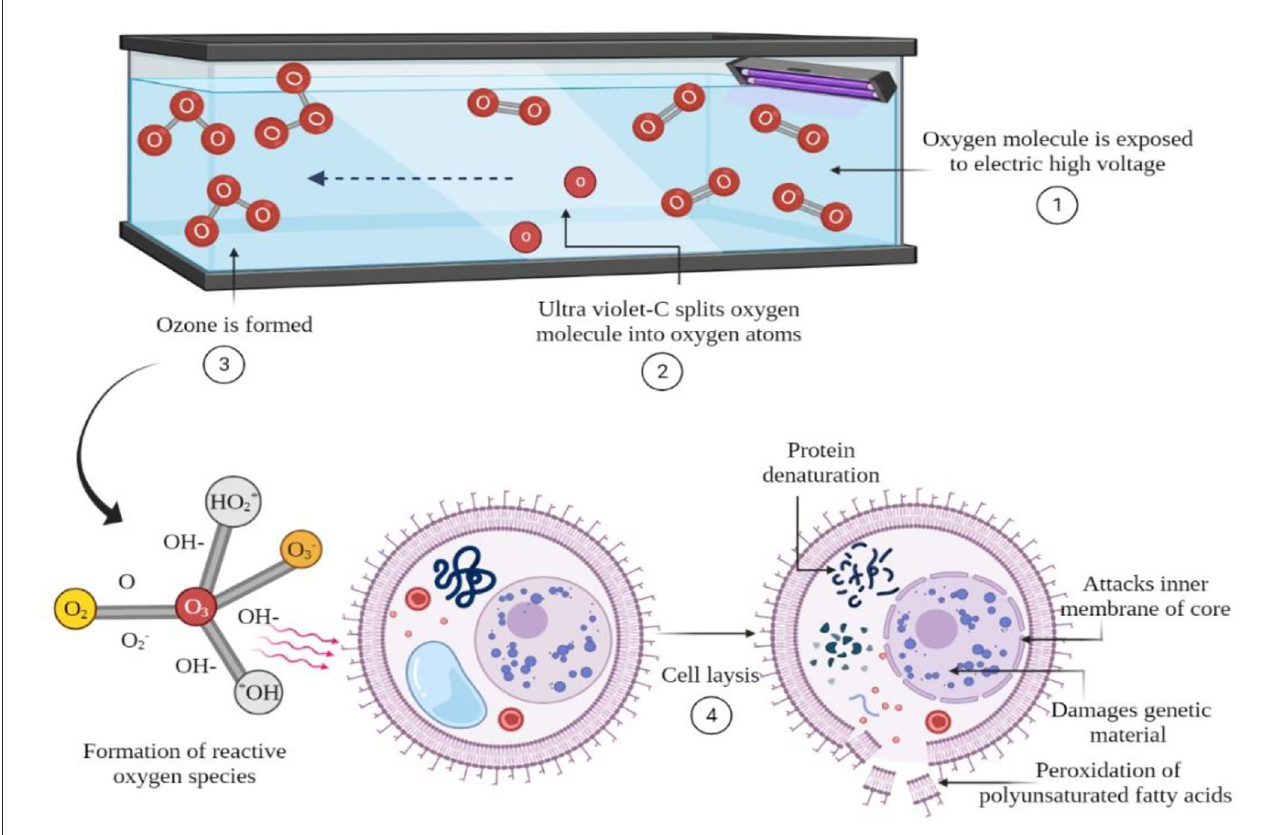
FIGURE1 Action mechanism of ozonated water imparting antimicrobial